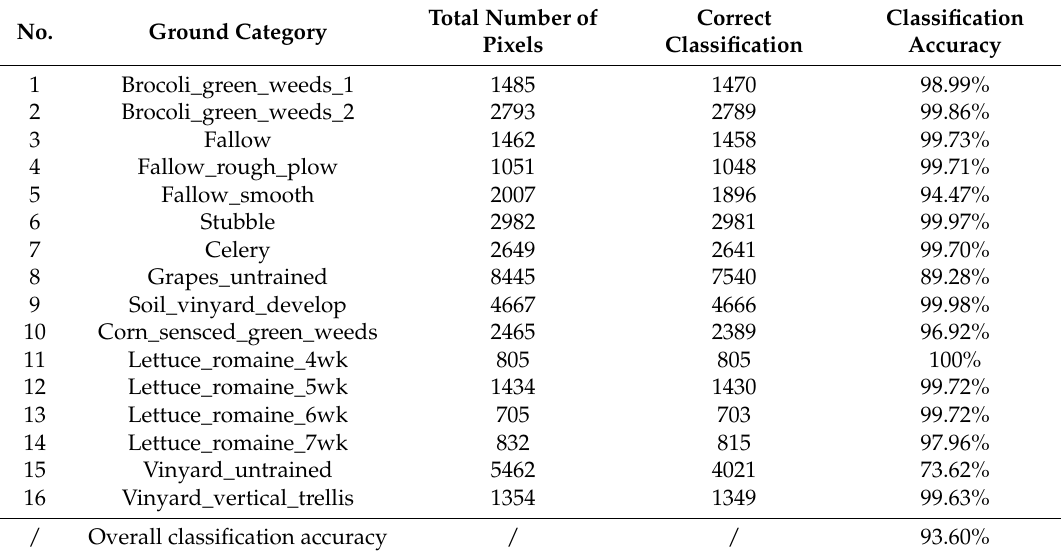
Table 12. Statistics of traditional CNN classification chart accuracy used Salinas